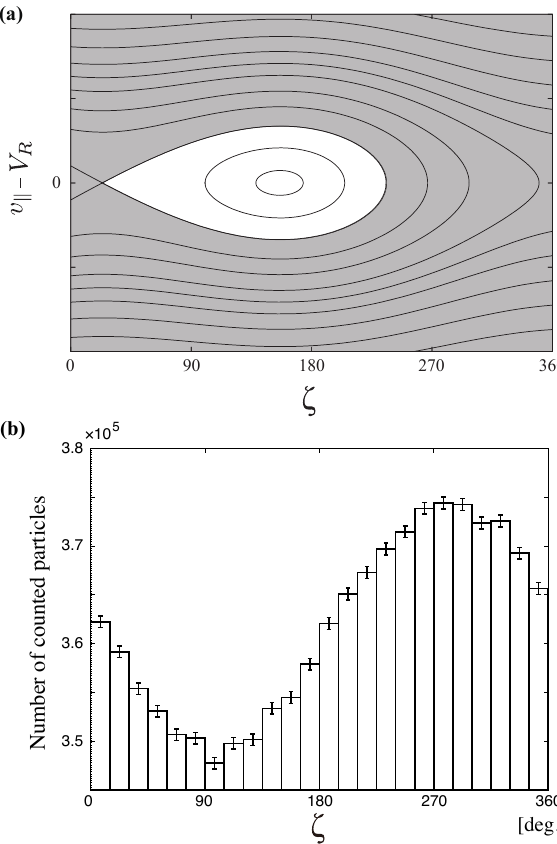
Fig. 5. (a) Trajectories of resonant electrons in v k − ζ phase space for the inhomogeneity factor S = − 0 . 4. (b) The accumulated distri- bution in ζ space of energetic electrons in Region A. The estimated statistical noise σ N (ζ) at each ζ bin is also